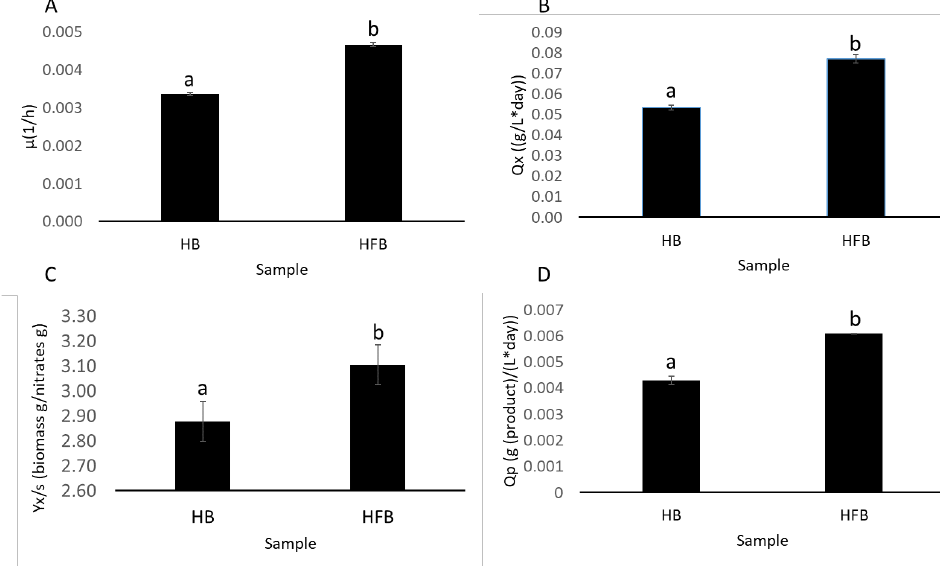
Figure 6. Comparative analysis of different kinetics and production parameters for M. salina cultures in different modes of cultivation and amount of nutrients. In this section of the results, all parameters were calculated 4 days after the nitrogen depletion in the growing medium and compared the results by ANOVA statistical analysis ( p < 0.05), “ a ” and “ b ” denotes significant differences. ( A ) Specific maximum growth rate. ( B ) Biomass productivity. ( C ) Substrate yield. ( D ) Volumetric productivity of β -glucans. HB: high-density batch. HFB: high-density fed-batch.